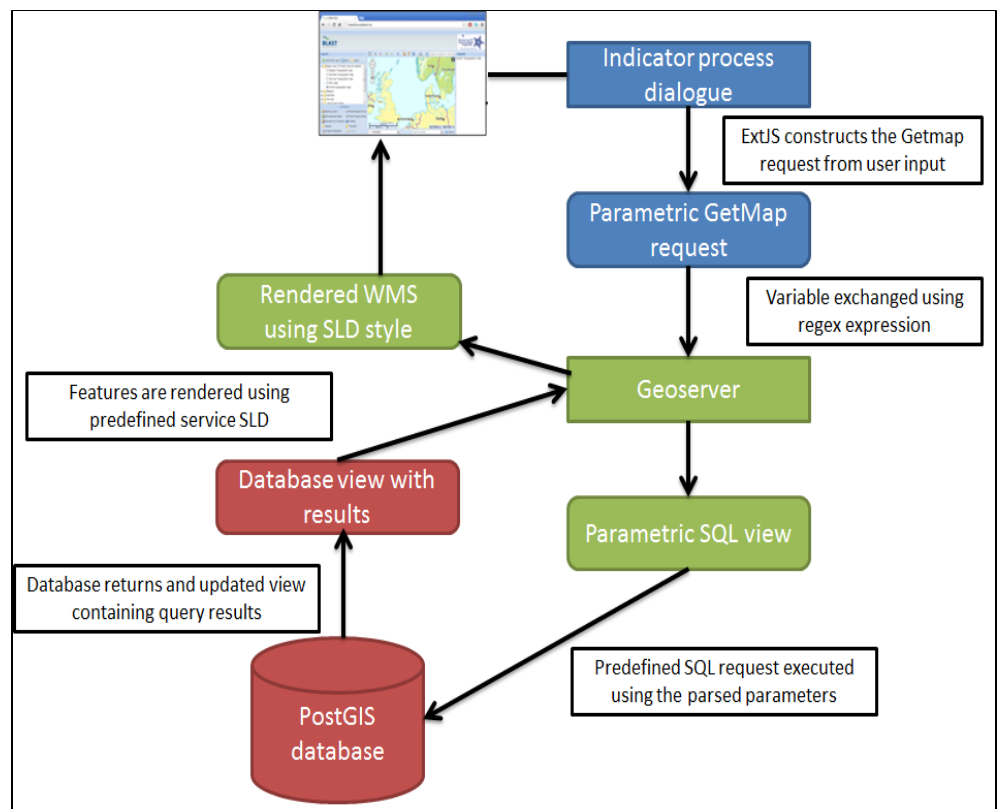
Figure 5. Data flow in the parametric view